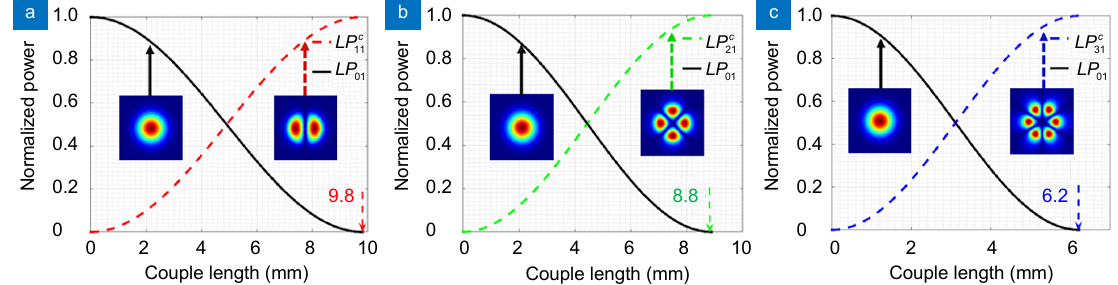
Fig. 2 | Normalized power conversion ( a ) from the LP MSC 2 , and ( c ) from the LP